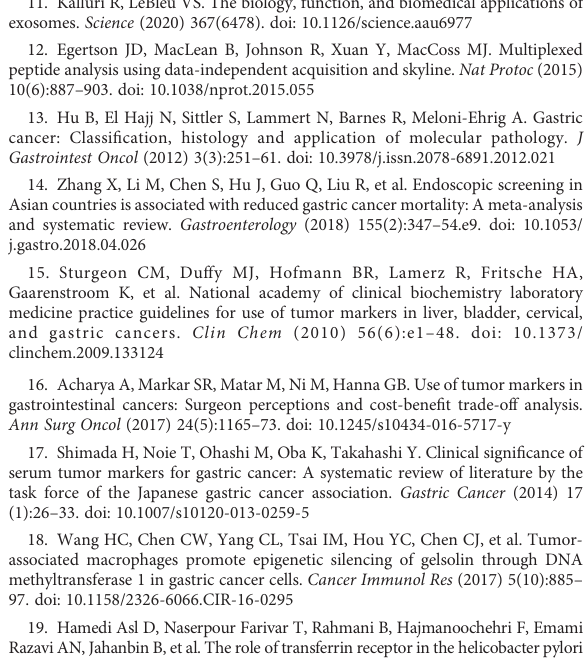
SUPPLEMENTARY FIGURE 1 Proteome data assessment of the two cohort. (A) Venn diagram of identi fi ed proteins in training cohort (cohort 1) and testing cohort (cohort 2). (B) Venn diagram of the identi fi ed proteins with the Vesiclepedia database. (C) Gene ontology analysis of shared EV proteins between training cohort and testing cohort. SUPPLEMENTARY FIGURE 2 Venn diagrams of differentially expressed proteins obtained in multi- group differential protein expression analysis for cohort 1. (A) Venn diagram of down-regulated proteins. (B) Venn diagram of up-regulated proteins. GC, GAC patients; HH, healthy individuals; S1, GAC patients of stage I + II; S2, GAC patients of stage III +